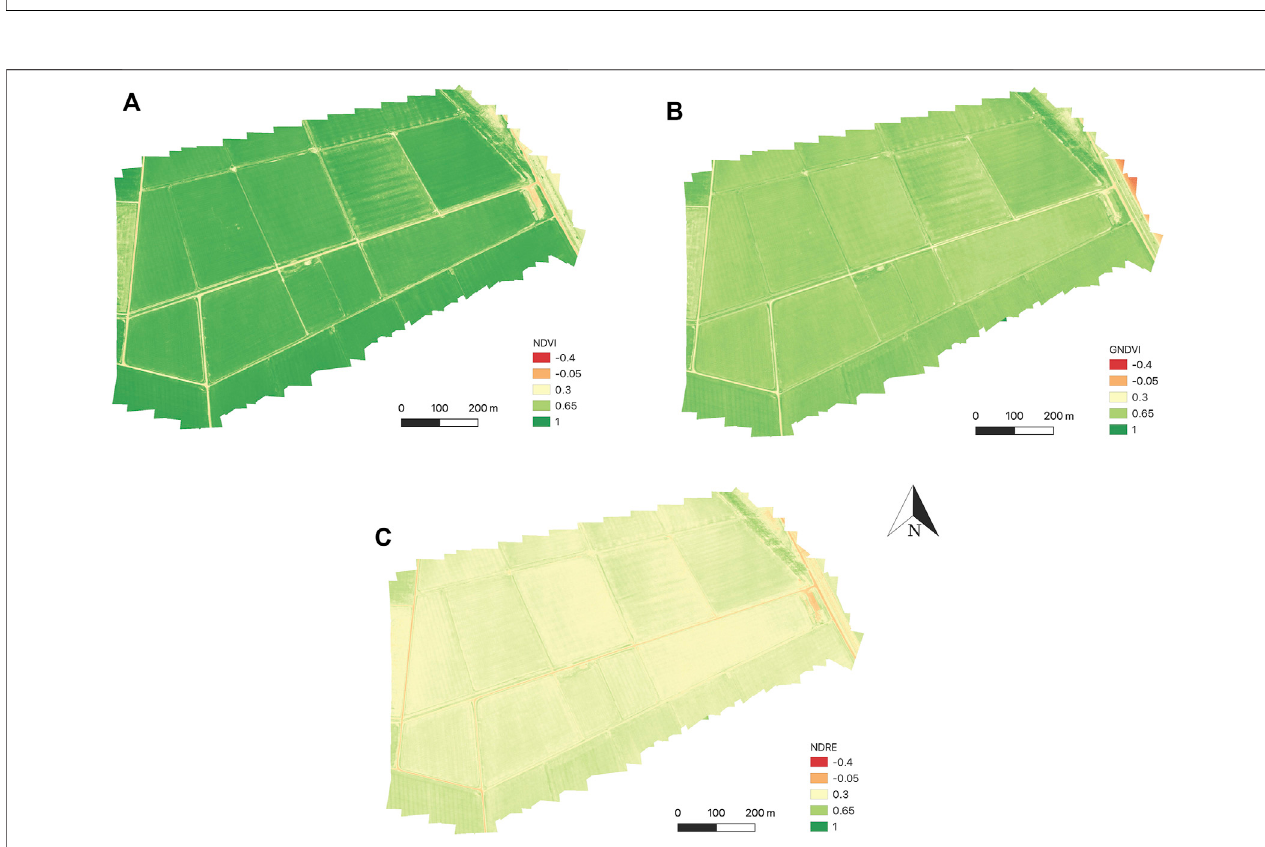
Frontiers in Remote Sensing |